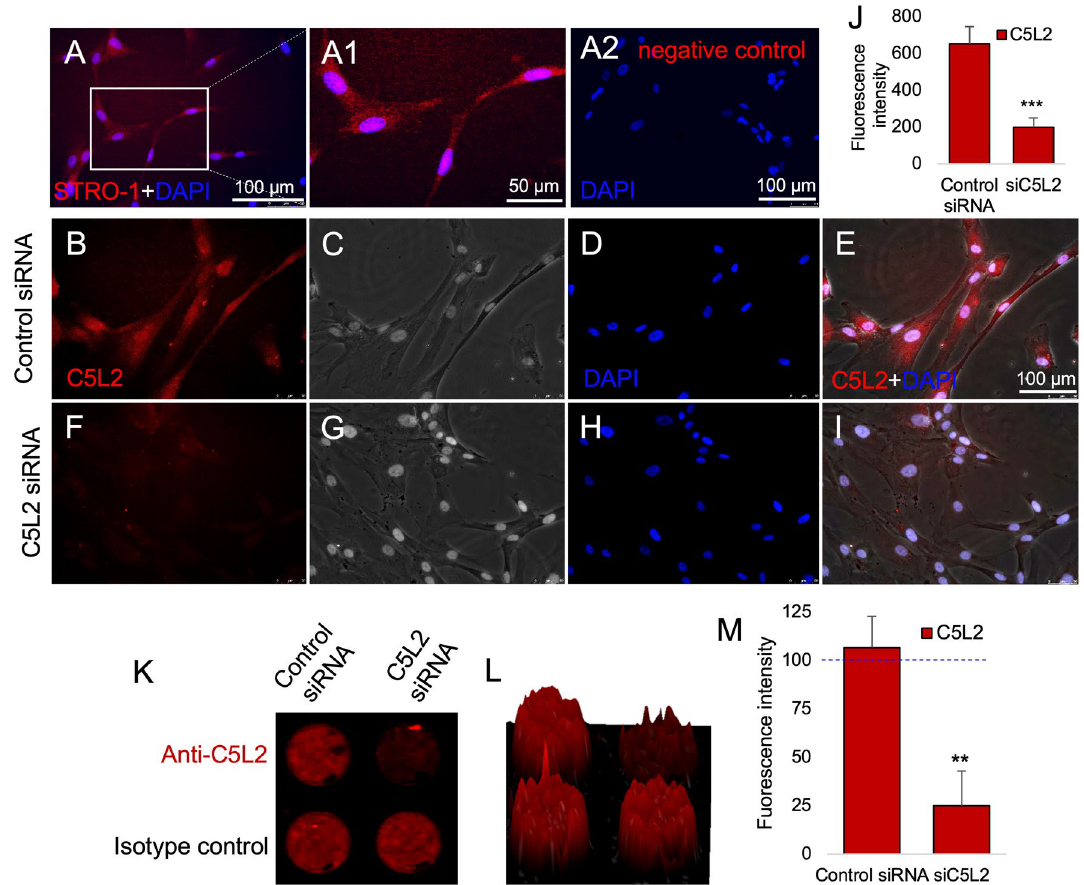
Figure 1. C5L2 siRNA treatment knocked down the C5L2 in DPSCs. ( A - A1 ) Commercial DPSCs were further confirmed with mesenchymal stem cell marker STRO-1. (A2) negative control for antibody. (B-I) To confirm